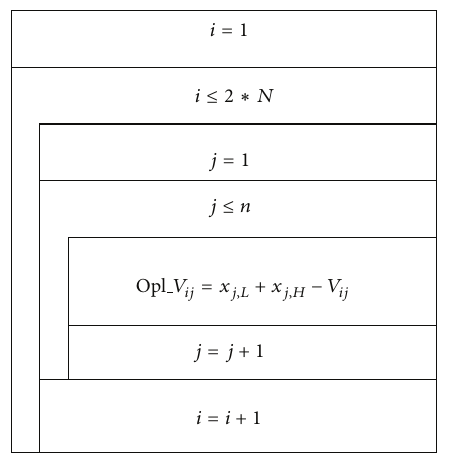
Figure 3: 𝑓 1 function convergence performance comparison.